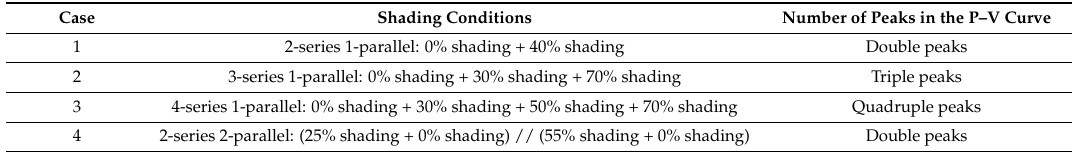
Table 6. Shading conditions of the four cases.